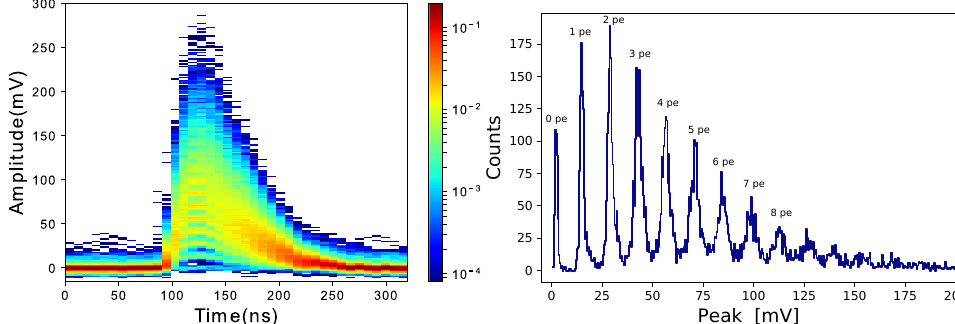
Figure 7. ( Left ): Waveform of the Hamamatsu S13360-1350CS under stimulation. ( Right ) Photo-electron spectrum resulting from integrating the area under pulse over a time window of